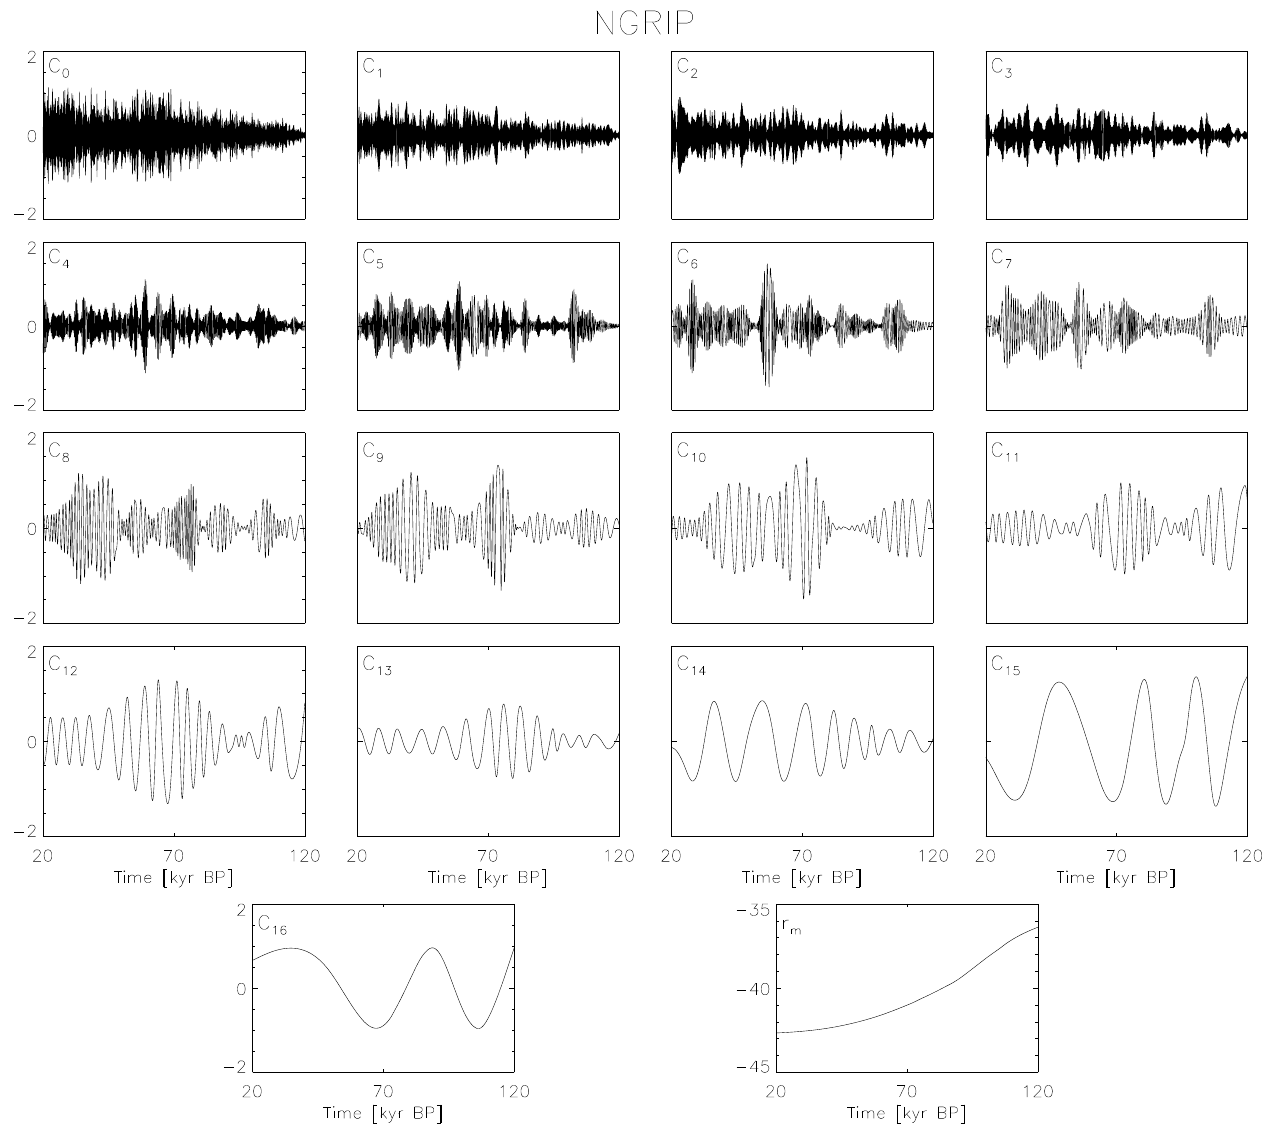
( t ) and residue r ( N ) m ( t ) for the NGRIP Fig. 3. IMFs C ( N ) j